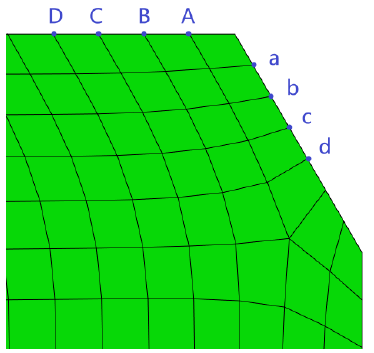
Figure 8. Enlarged view and the selected nodes along the slab corner before deformation.